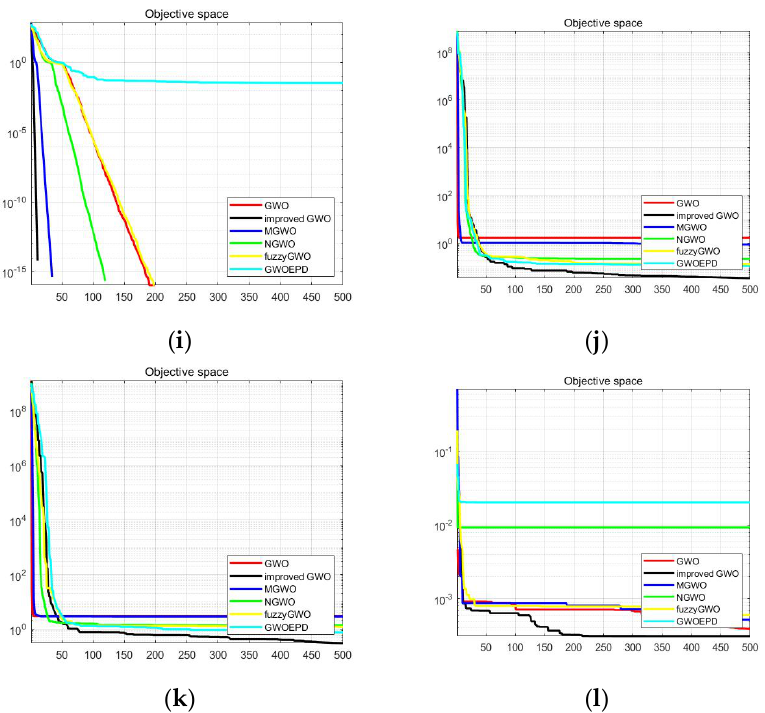
Figure 5. Convergence curves of algorithms on test function. ( a ) f1 function; ( b ) f2 function; ( c ) f3 function; ( d ) f4 function; ( e ) f5 function; ( f ) f7 function; ( g ) f8 function; ( h ) f9 function; ( i ) f10 function; ( j ) f11 function; ( k ) f12 function; ( l ) f14 function. Table 1. Parameter Configuration.